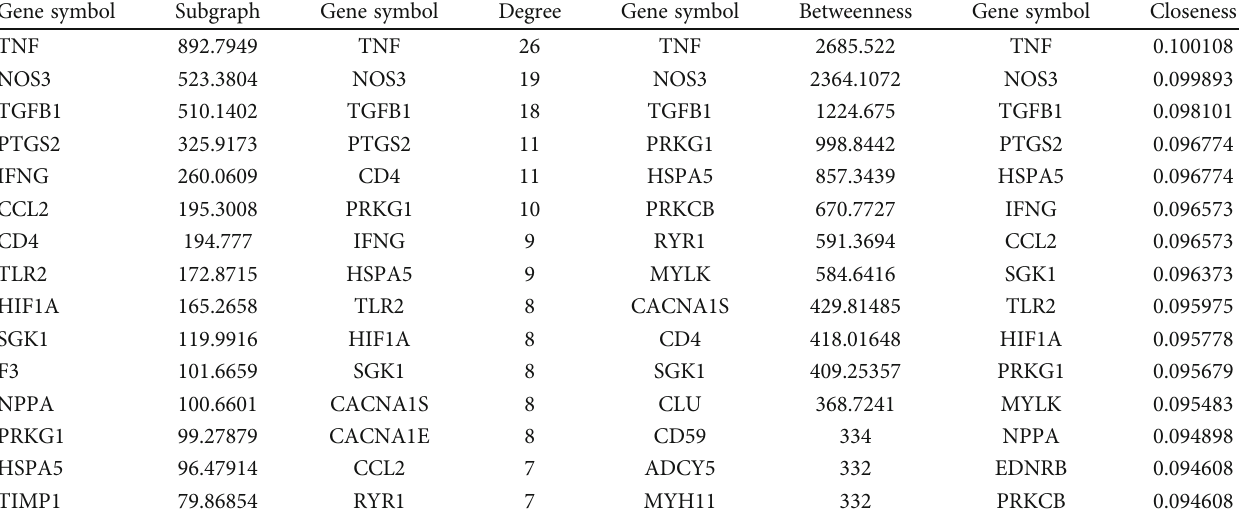
Table 1: The top 15 nodes with the highest scores for the 4 centrality